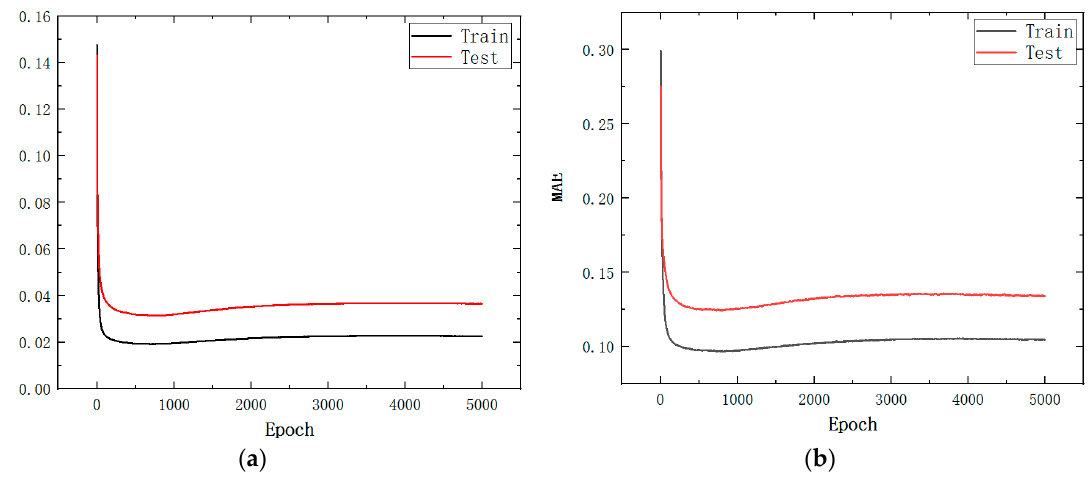
Figure 4. The function changes during training. ( a ) Mean square error. ( b ) Absolute value error variation.